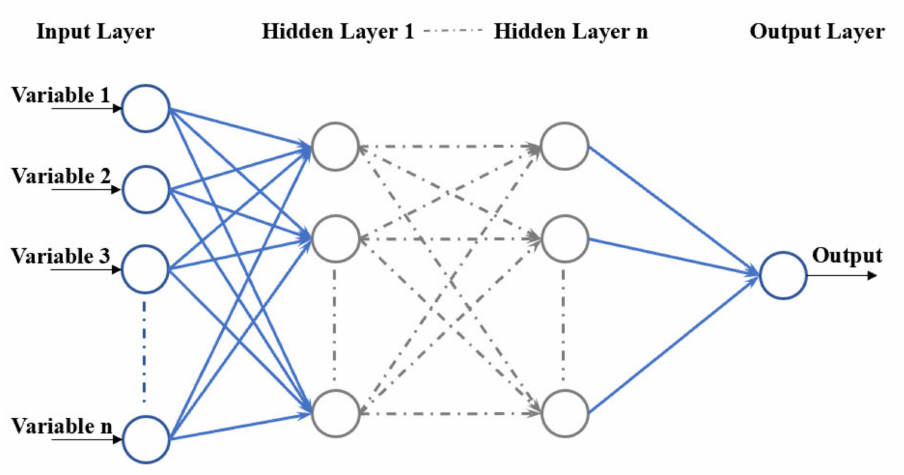
Figure 1. Structure of ANN network.